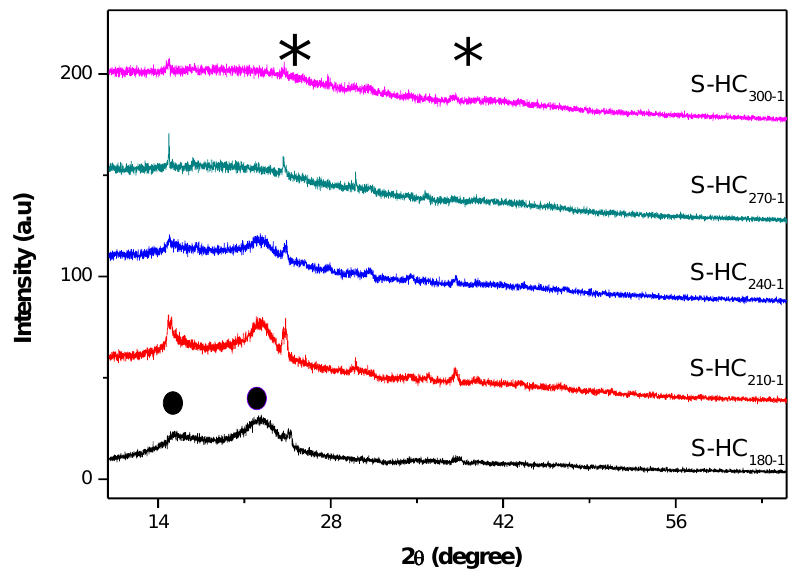
Figure 3. X-ray diffractograms of the hydrochar obtained at different temperatures after 60 min of reaction time. ( • reflections of crystalline cellulose; * reflections of turbostratic structure of disordered carbon).